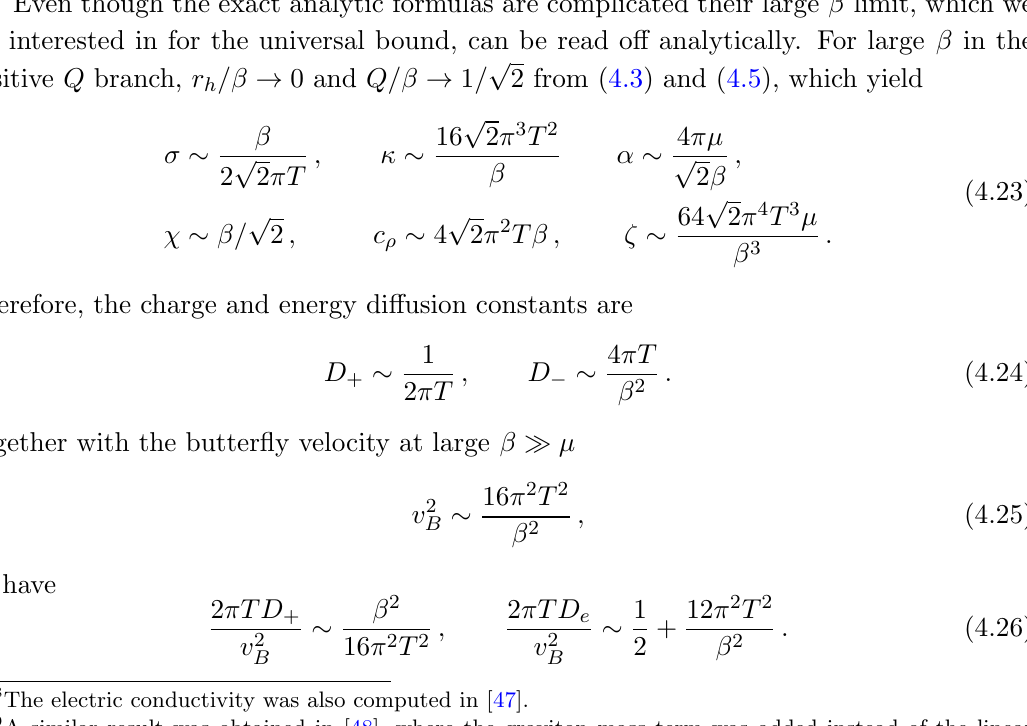
Figure 5 . Di(cid:11)usion constants of the axion-dilaton model at (cid:12)nite density. (cid:22)=T = 0 : 1 ; 1 ; 5 from left to right. The blue curve is for D + and the red curve is for D (cid:0) . The green curve displays v 2 and 2 (cid:25)TD (cid:0) =v 2 saturates the universal value in the incoherent regime: (cid:12)=T (cid:29) 1 and (cid:12)=(cid:22) (cid:29) 1. B